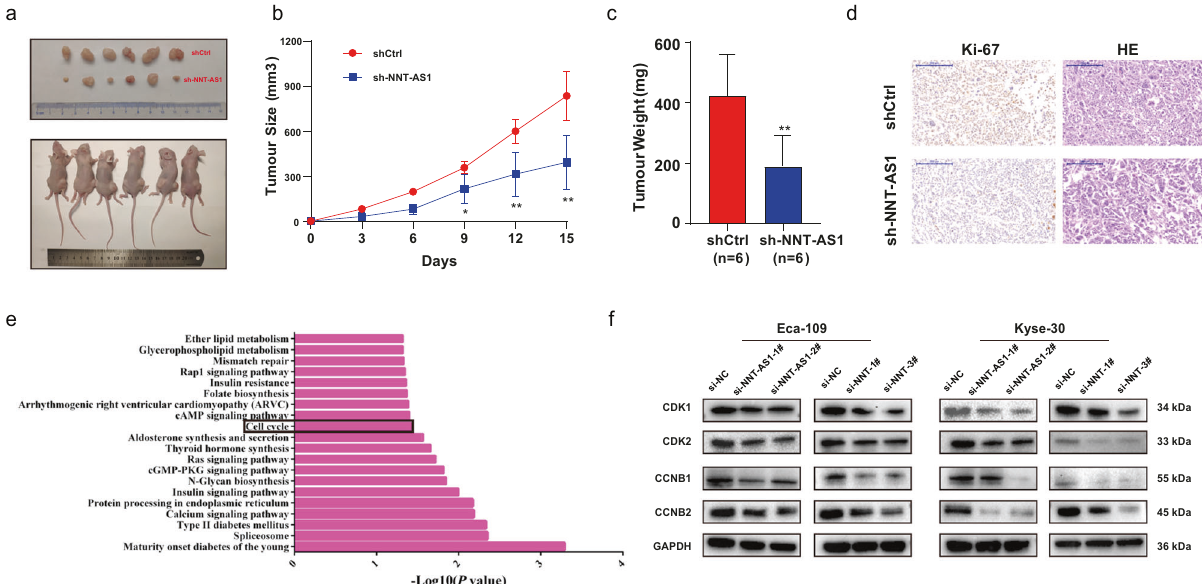
Fig. 7 NNT-AS1 promoted cell growth in vivo and could regulate the cell cycle signaling pathway. a ShCtrl or shNNT-AS1 was stably transfected into Eca-109 cells, which were respectively injected into the back of nude mice; b tumor volumes were measured every 3 days and the growth curve of tumors was plotted; c the tumor weight in the shCtrl group was higher than that in the shNNT-AS1 group; d the tumor sections were undergone ki-67 staining and HE staining; e pathway enrichment analysis was conducted to predict the potential pathways that NNT participated in ESCC; f several checkpoints of cell cycle pathway were measured using western blot assays after silencing NNT and NNT- AS1. The results were from three independent experiments. Data were analyzed by unpaired Student ’ s t -test. *** P < 0.001, ** P < 0.01, * P < 0.05. Variables were presented as the Mean ±